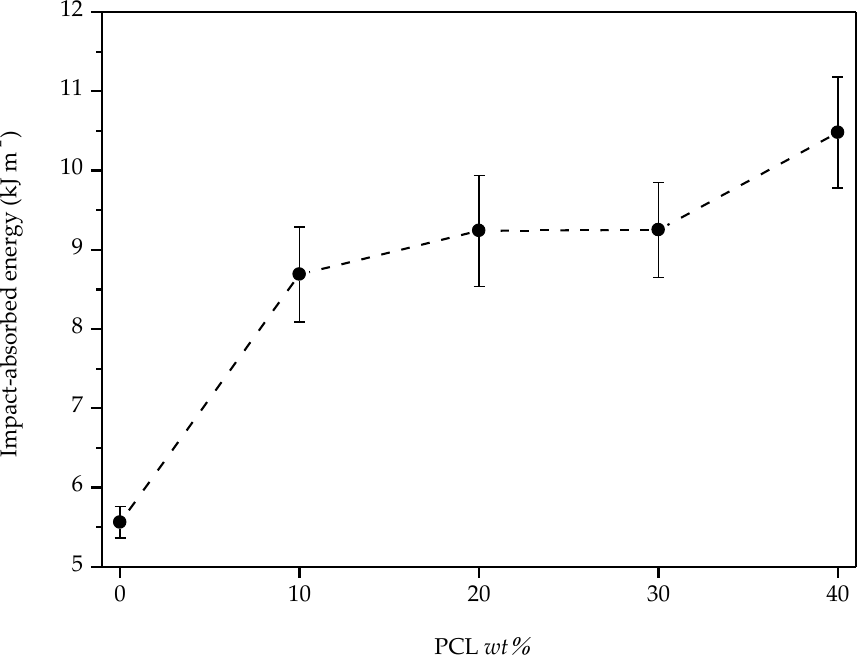
Figure 4. Plot evolution of the impact-absorbed energy of neat PHBH and PHBH / PCL blends with increasing PCL wt %.